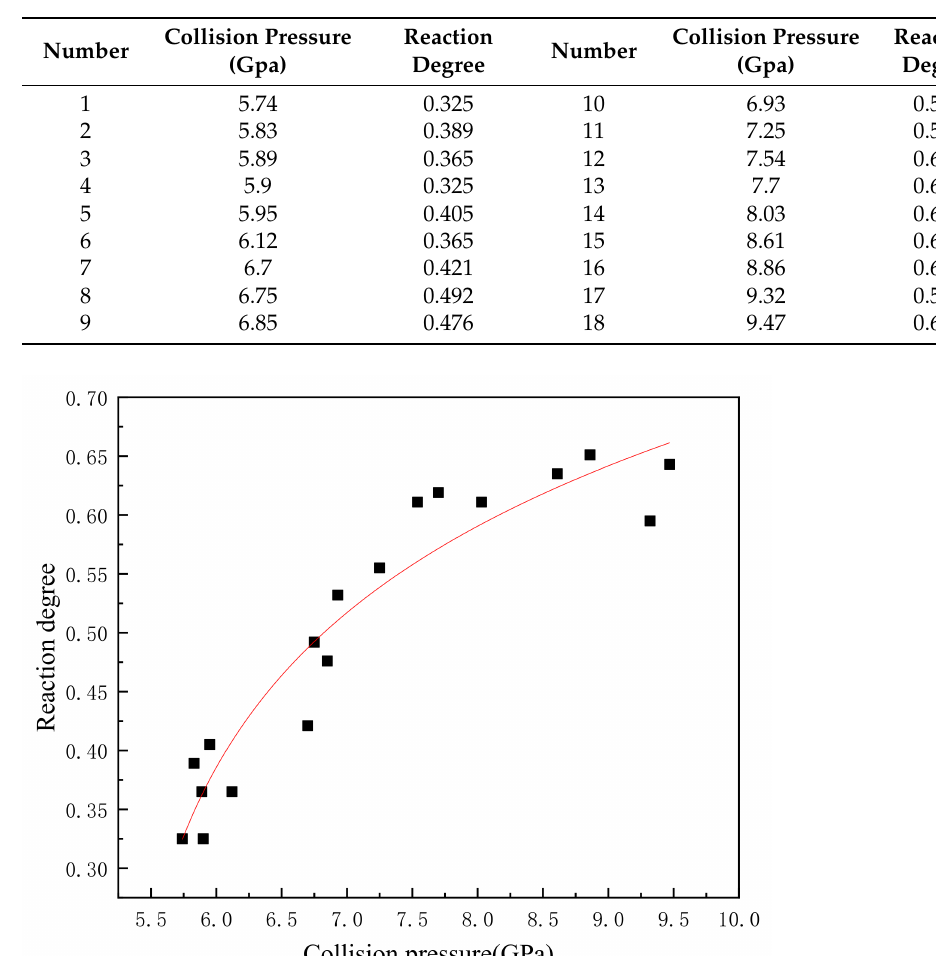
Table 5. The relationship between collision pressure and reaction degree of PTFE/Al [15].